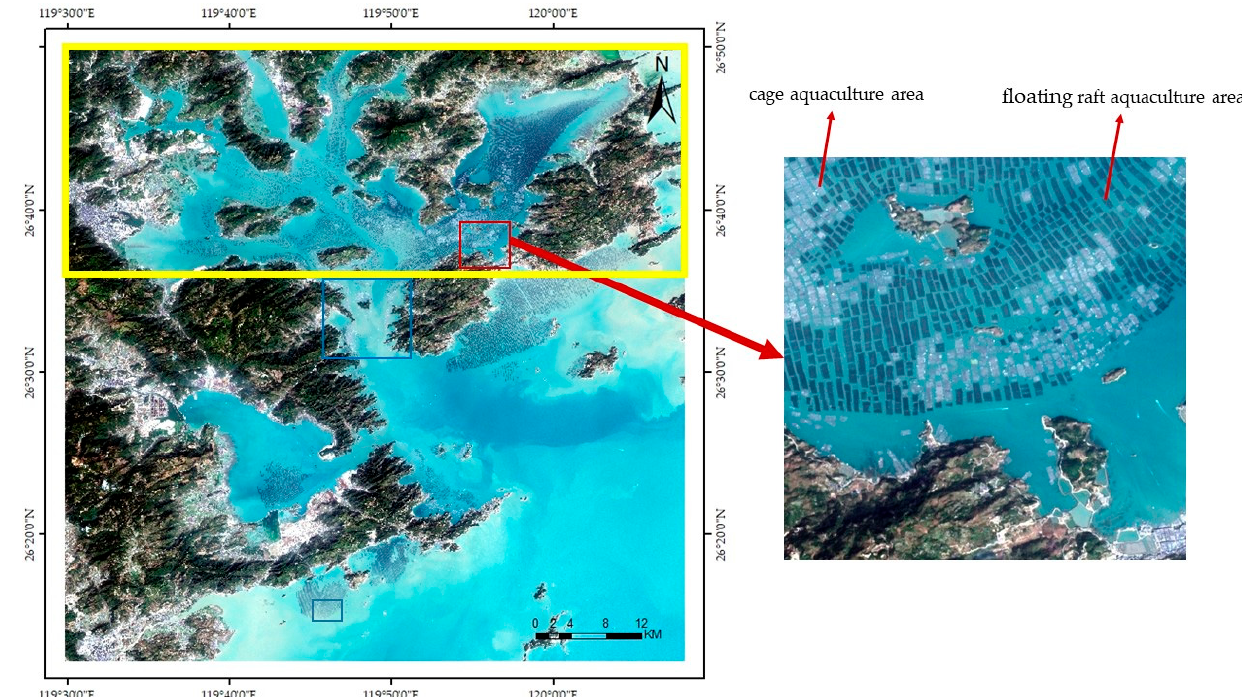
Figure 1. The sea area where Sansha Bay and Luoyuan Bay are located is an important marine aquaculture area in Fujian Province. The left of the picture here is the geographic location of the study area, and the right of the picture is an example of images of the cage aquaculture area and the floating raft aquaculture area. The yellow box area of the image was mainly used for training and validation, while other areas were used for testing. The blue box area of the image was the typical study area we chose.